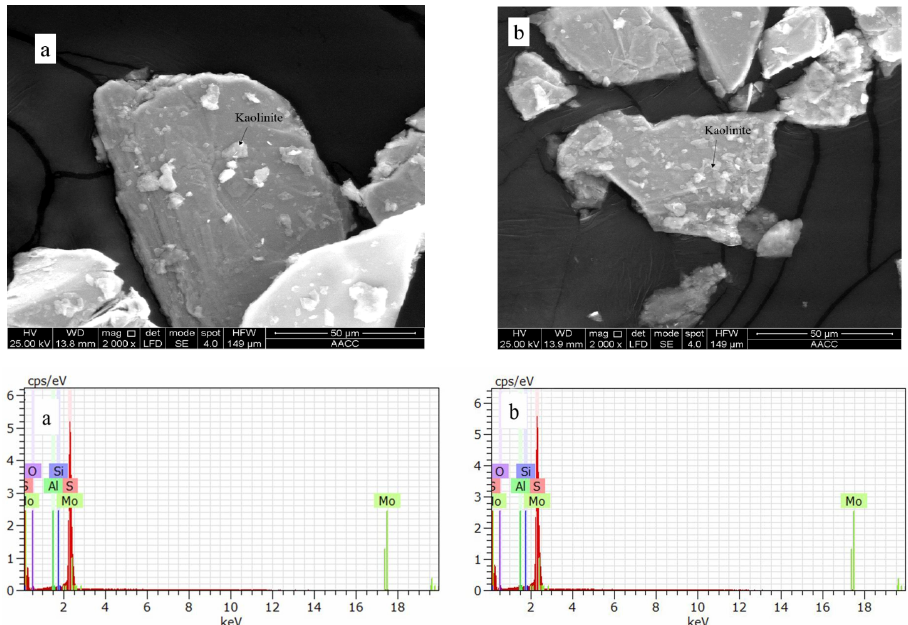
Figure 6. SEM image and EDS analysis of froth product in gypsum solution: ( a ) SEM image and EDS analysis of froth product in 200 mg/L; ( b ) SEM image and EDS analysis of froth product in 800 mg/L gypsum solution.